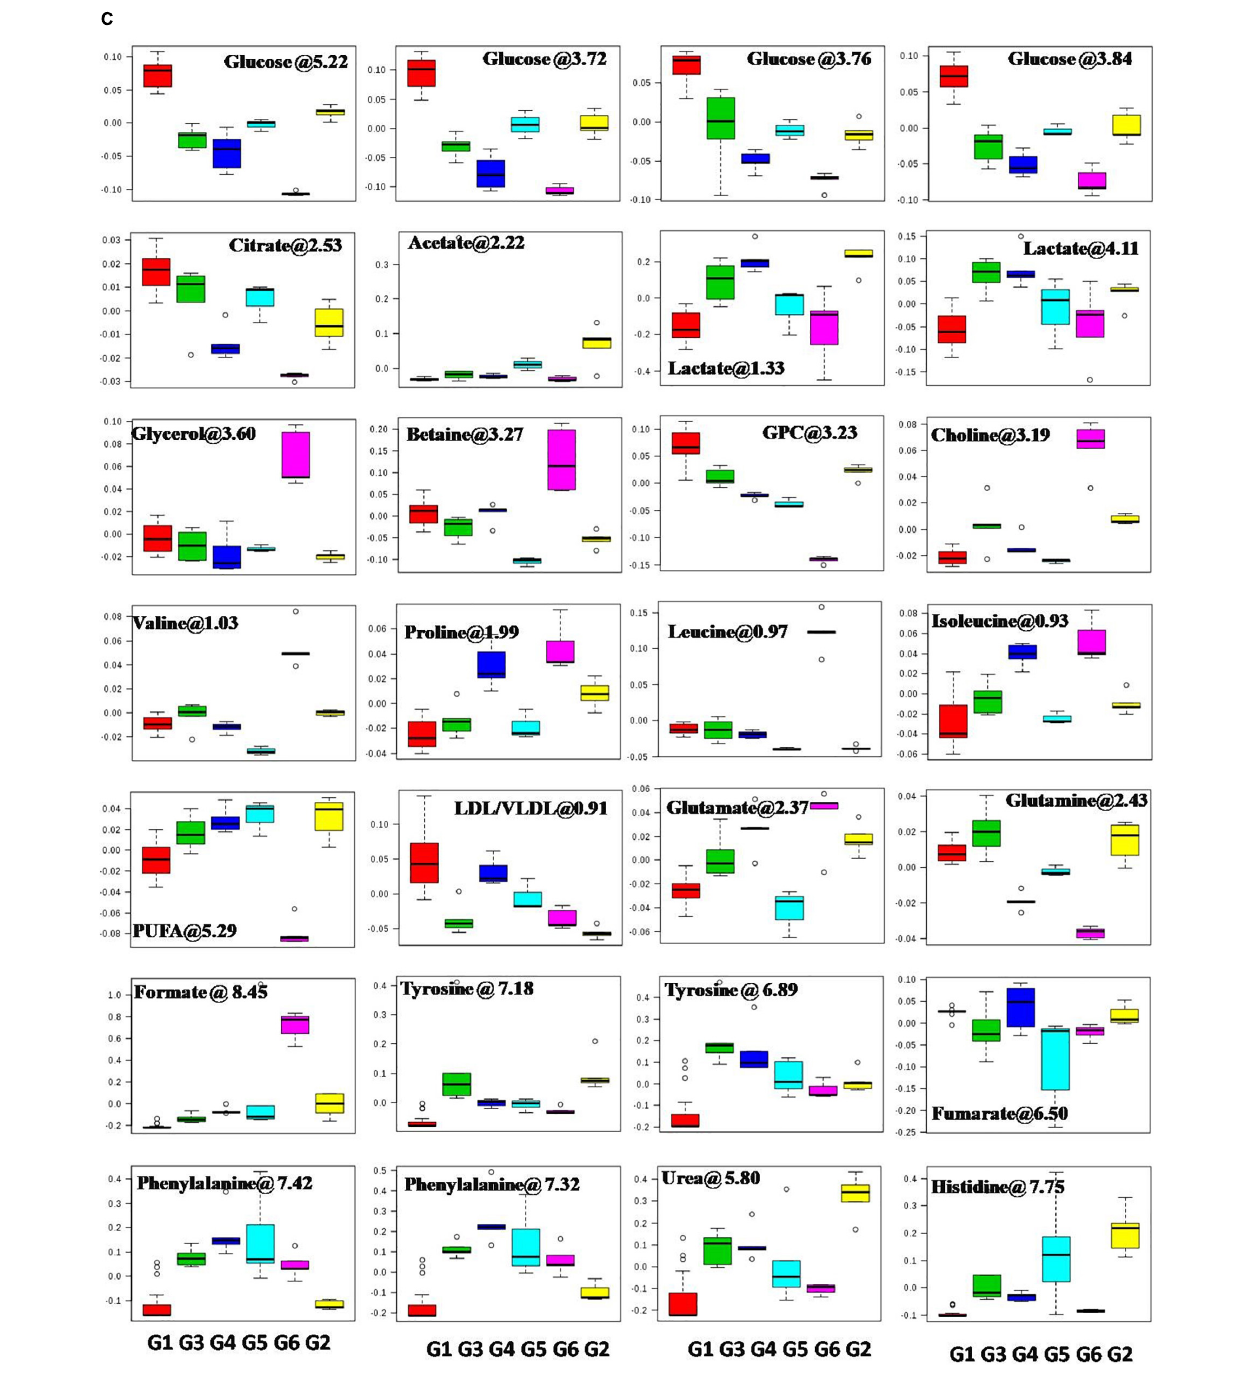
FIGURE 3 | (A) Stock plot representation of 1D-H-NMR of serum metabolites of experimental rats. NMR spectra of serum samples are represented in distinguishing color formats (A– F shown in the above figure). The peaks annotated in the figure below show the assignment of serum metabolites. The abbreviations used are as follows: LDL/VLDL, low/very-low-density lipoproteins; PUFA, polyunsaturated fatty acids; BCAA, branch chain amino acids; Leu, leucine; NAG, N -acetyl glycoproteins; Arg, arginine; Lys, lysine; m-I, myo-inositol; GPC, glycerol phosphocholine; and glucose resonances are indicated using an asterisk ( ∗ ). (B) 2D-PLS-DA score plot of rat serum metabolites. The combined 2D-PLS-DA score plots between the groups clearly indicated that the DMBA-induced metabolic changes were essentially reset to their average levels after voacamine and vincristine treatment in monotherapy and with combined therapy of both drugs, as inferred by the decreased separation between the treated and regular control groups. (A) The complete CPMG data matrix was used for PLS-DA modeling; (B) the upfield spectral region (from 5.4 to 8.6 ppm, aromatic region) was excluded from the data matrix to evaluate the discriminatory significance of aromatic residues. The